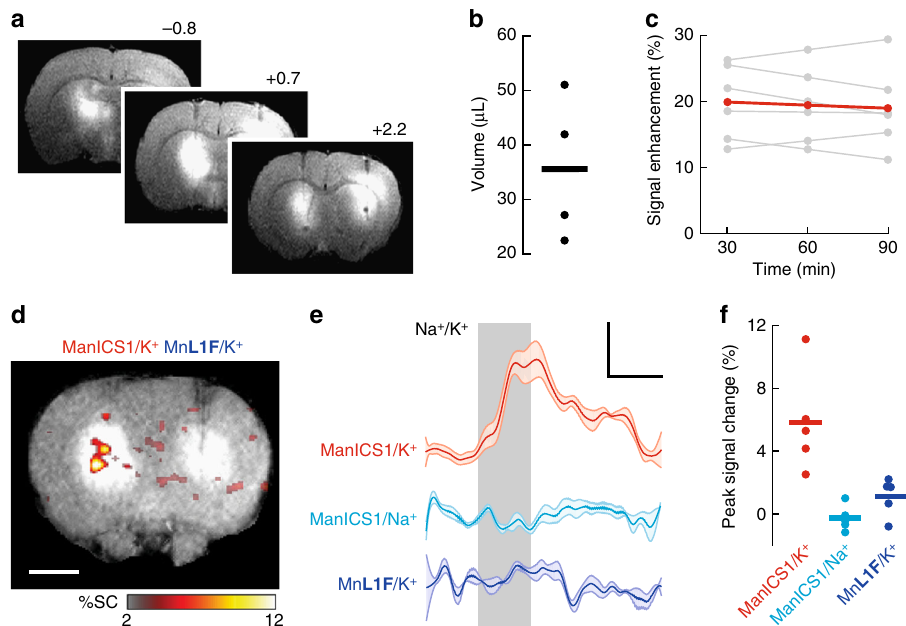
Fig. 5 ManICS1-AM enables detection of neural activation in rat brain. a T 1 -weighted MRI showing broad contrast enhancement following infusion of 15 µ L ManICS-1 (left) or calcium-insensitive control agent (Mn L1F , right) into rat striatum. Rostrocaudal coordinates with respect to bregma indicated. b Estimated volume of signal enhancements within 10% of peak values after ManICS1-AM infusion in four animals (mean = 36 ± 7 µ L). c Plot of peak MRI signal in ManICS1-AM infused brain regions over time shows a mean signal enhancement of 20 ± 2% with an average of 0.9% signal decrease per hour with respect to image intensity in unenhanced tissue (red); the signal decrease from 30 to 90 min post infusion was not statistically signi fi cant ( t -test p = 0.42, n = 6). Data from individual animals shown in gray (scale bar = 3 mm). d 1 µ L K + infusion causes T 1 -weighted MRI signal increases in the presence of predelivered ManICS1-AM (left) but not Mn L1F (right). Average peak signal change across multiple animals ( n = 5) is indicated by the color scale superimposed on a high resolution T 1 -weighted image of a representative rat. Scale bar = 3 mm. e Region of interest analysis shows the time course of signal changes observed during K + or Na + in the presence of ManICS1 (red and cyan, respectively), and during K + stimulation (vertical gray bar) in the presence of calcium-insensitive Mn L1F (blue). Shading represents SEM of fi ve measurements. f MRI signal changes observed in individual animals within one minute of K + or Na + treatment offset for the conditions in e . Mean signal changes observed during potassium stimulation in the presence of ManICS1-AM was signi fi cantly greater than results from both controls ( t -test p ≤ 0.016, n =